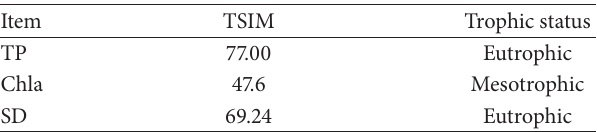
Table 4: Assessment results of trophic status index of Baiyangdian Lake in